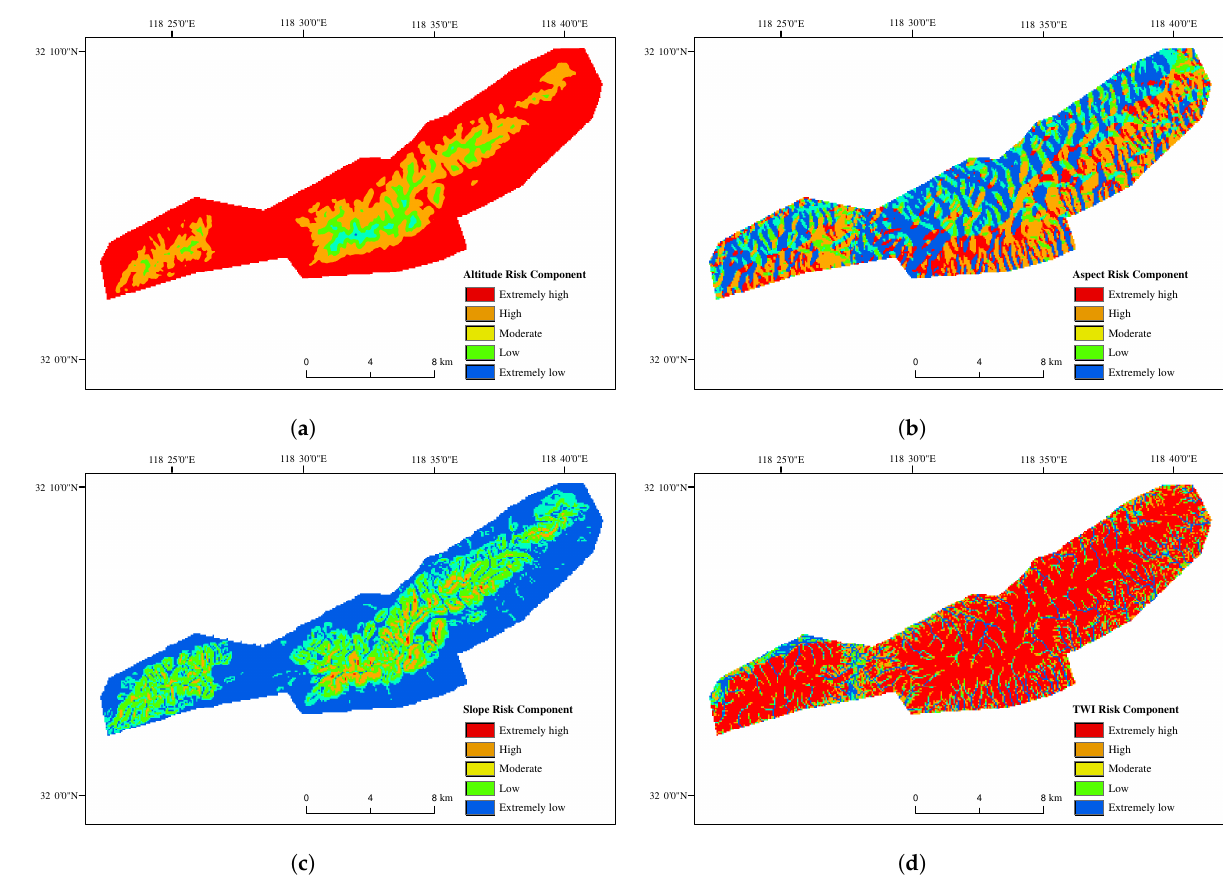
Figure 11. The fire risk map of topographic factors. ( a ) The risk map of altitude. ( b ) The risk map of aspect. ( c ) The risk map of slope. ( d ) The risk map of TWI. The fire risk level of each factor is determined by the fire risk classification results. NDVI is the normalized vegetation index, with a value ranging from − 1 to 1. A value less than 0 means that the area is covered by water, snow, etc. If NDVI is 0, it indicates that the area is covered by rocks and bare soil, and a value greater than 0 means that this area is covered by vegetation. The higher the vegetation coverage, the greater the NDVI value. The central part of Laoshan National Forest Park is a forest area with full vegetation coverage, which is shown in Figure 8. The marginal areas of the central rear are roads and populated areas, so the vegetation coverage is low. Thus, the fire risk of this area is high. The NDVI base layer is shown in Figure 12a.